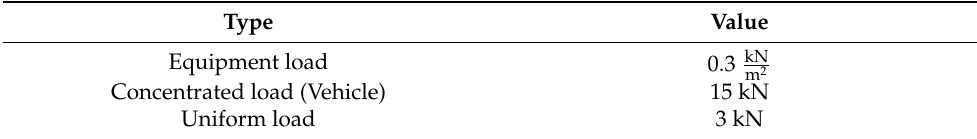
Table 7. Loads for analysis (KDS 41 10 15).